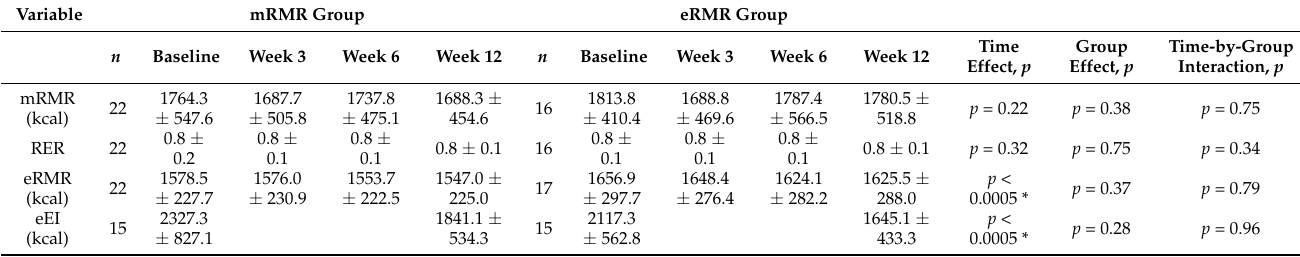
Figure 8. Triglycerides (mmol/L) measured at baseline and week 12 for the mRMR ( n = 20) and eRMR groups ( n = 18). 3.18. Energy Intake Table 5. Metabolic outcomes and estimated energy intake for groups across the intervention period.